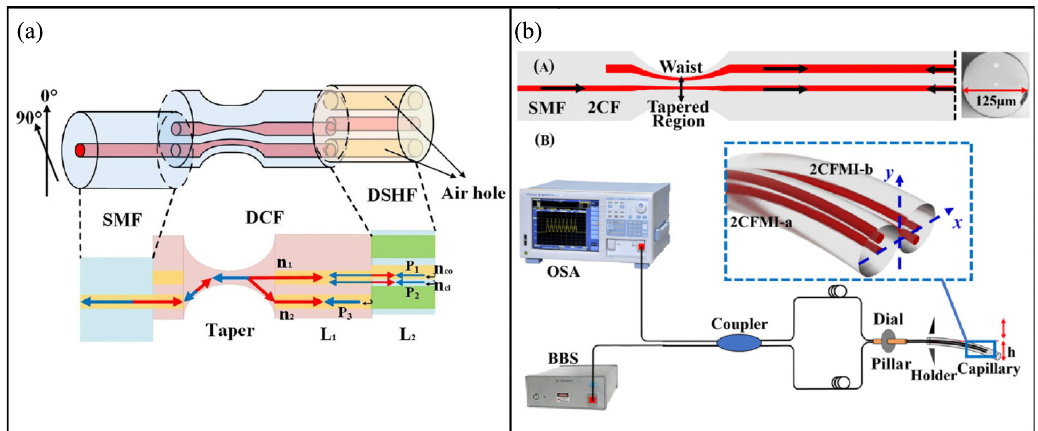
Figure 7. Schematic diagrams of the Vernier effect fiber sensors based on paralleled MIs, ( a ) the sensor consists of an asymmetric dual-core fiber and a short section of DSHF [56], ( b ) the sensor consists of a pair of parallelized dual-core fiber MIs [57], ( A ) the sensor probe, ( B ) the schematic diagram of experimental system. Reprinted with permission from Ref. [56] ©Elsevier. Reprinted with permission from Ref. [57] ©The Optical